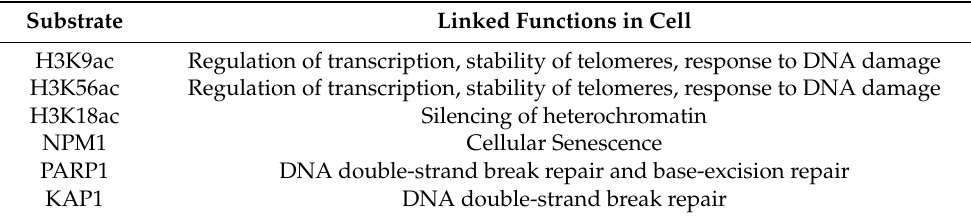
Table 1. A few substrates of SIRT6 and their linked functions in cell-related to aging (adapted from reference